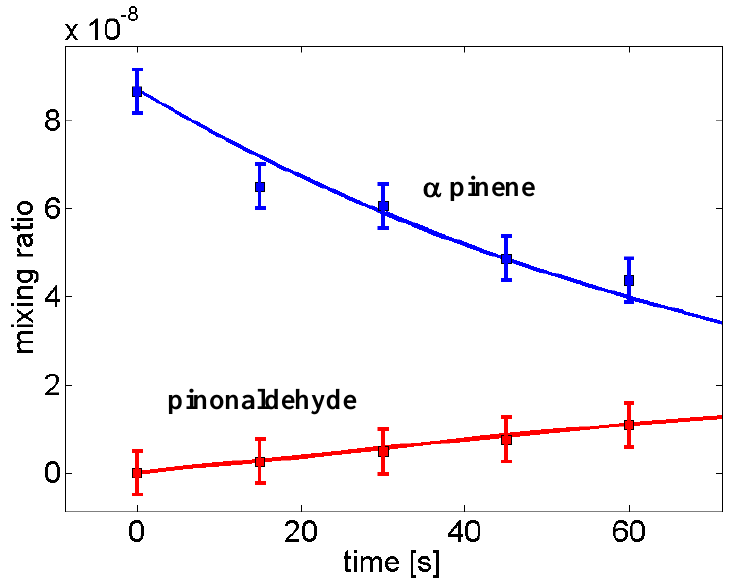
Figure 1. Absolute VOC concentration determination with PTR-TOF-MS. Predicted and measured decrease of alpha-pinene concentrations in a flowtube along with the production of the dominant first order generation product pinonaldehyde upon exposure to ozone. Comparison between model prediction (solid lines) of mixing ratios for alpha-pinene (blue) and pinonaldehyde (red) and measured values by PTR-ToF-MS using Equation 4 (squares) showing an agreement within 10%. Reprinted with permission from ref [23]. Copyright 2012 American Chemical